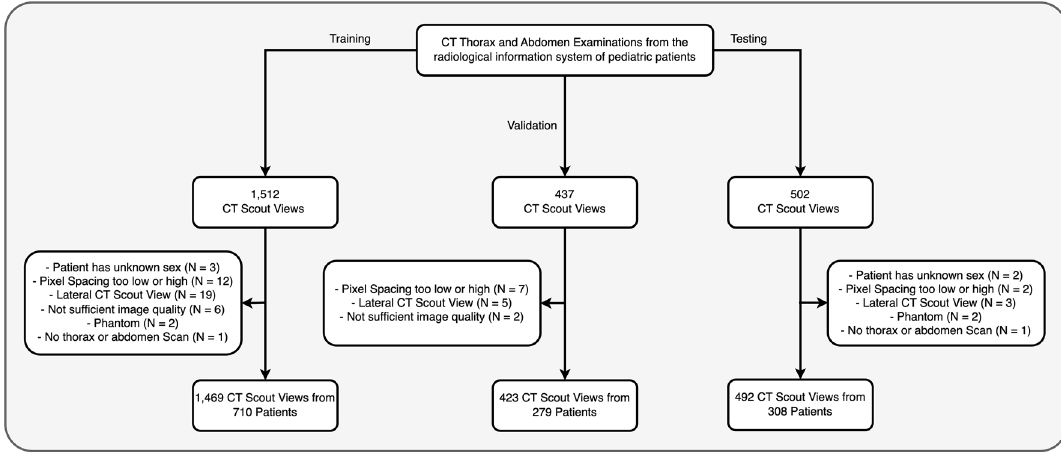
Figure 2. Patient flowcharts with inclusion and exclusion criteria.